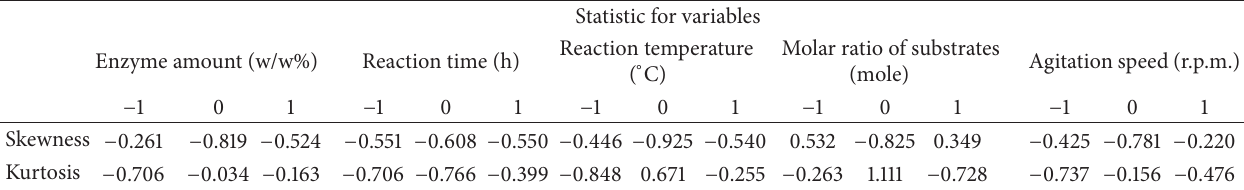
Table 2: Descriptive statistics to check the skewness and kurtosis values for five variables.